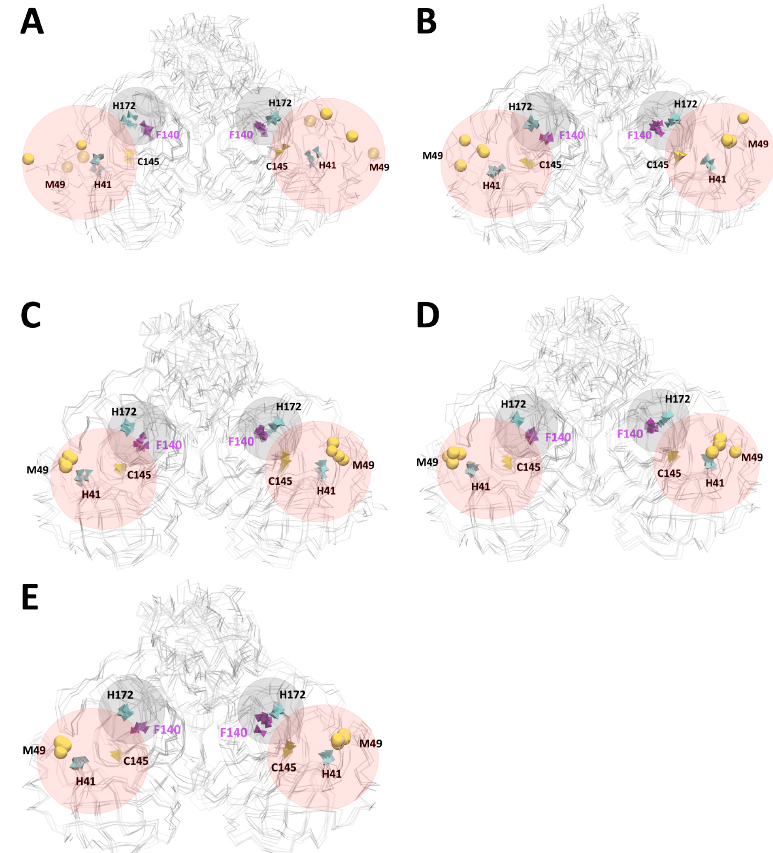
Figure 6. Snapshots of the last frame of all microstates in Mpro, highlighting the active site (pink area) and pocket S1 (gray area). ( A , B ) pH 3 and pH 4 did not show a constant Met49–Cys145 distance, which was also analysed in the RMSF, where the Met49 residue showed high fluctuations at these pHs. ( C – E ) pH 5, pH 6 and pH 7 with a constant distance between Met49-Cys145, His41-Cys145 and His172-Phe140. The His41, His172, Cys145 and Phe49 residues (polyhedral graphic representation) and Met49 (bead graphic representation) are